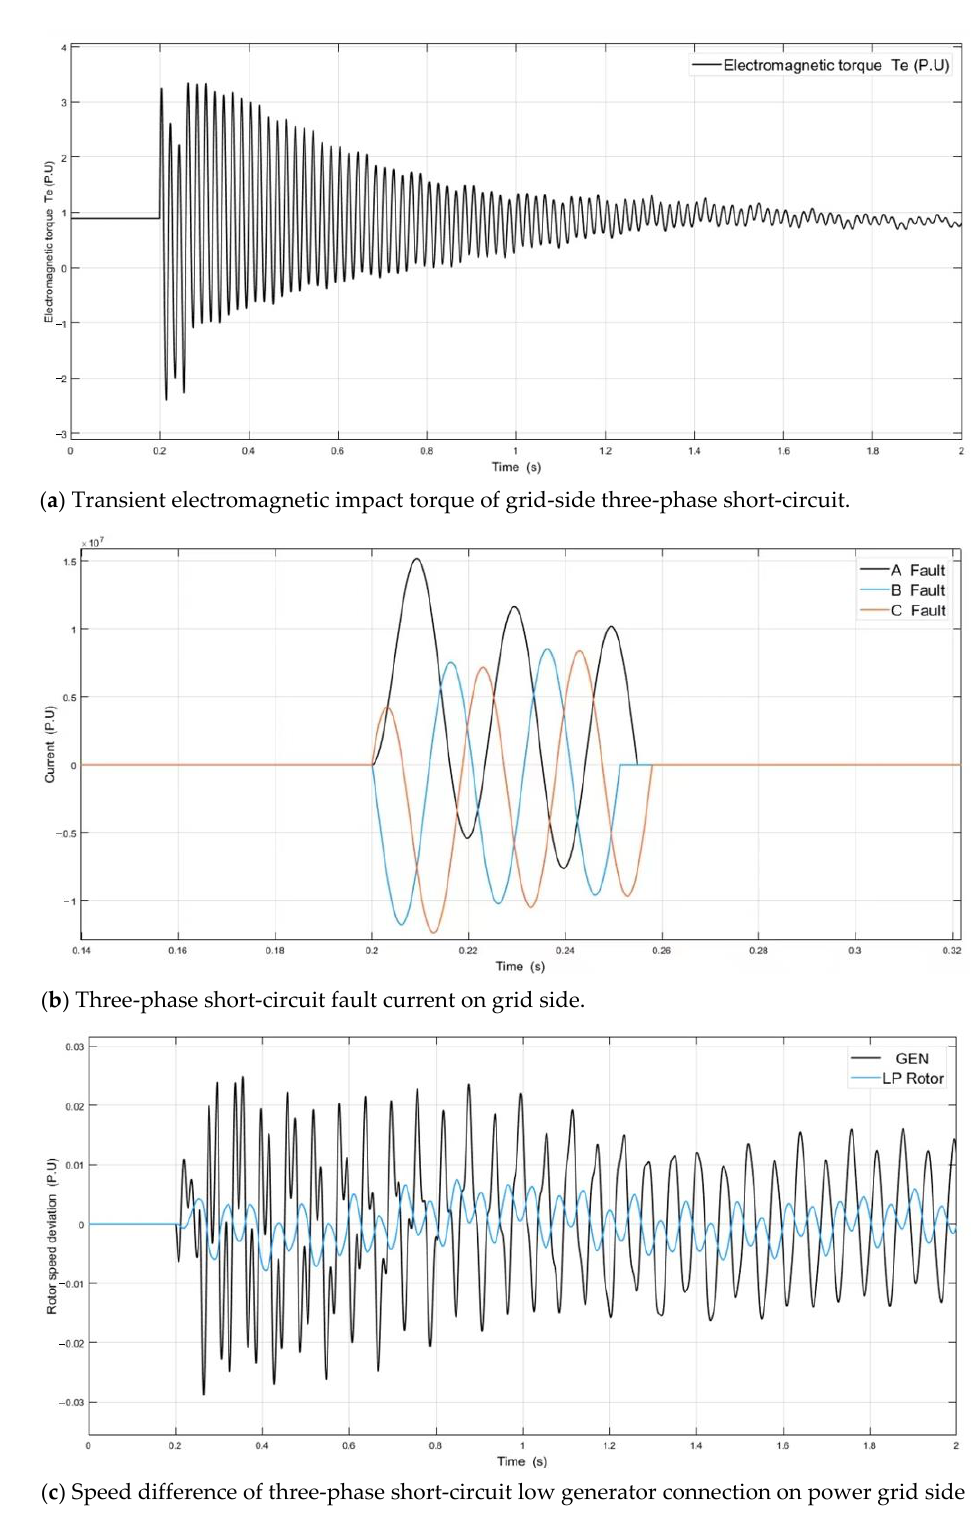
Figure 9. Characteristic curve of three-phase short circuit fault .